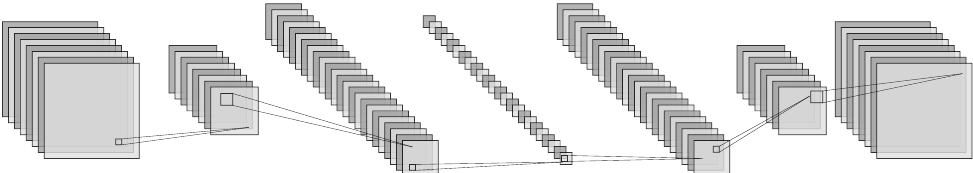
Figure 2. A high-level illustration of a DL semantic segmentation network architecture. Layered squares represent feature maps. The connection between stacked feature maps represents convolu- tional operations. This figure is created using the tool from